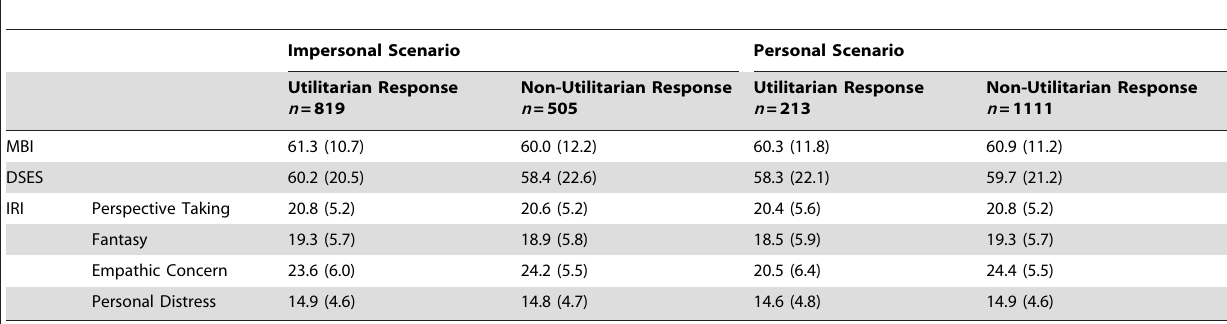
Table 2. Mean ( SD ) values for moral knowledge, religiosity, and empathy questionnaires for participants who responded ‘‘YES’’ or ‘‘NO’’, independently, to each moral scenario from Experiment 1.